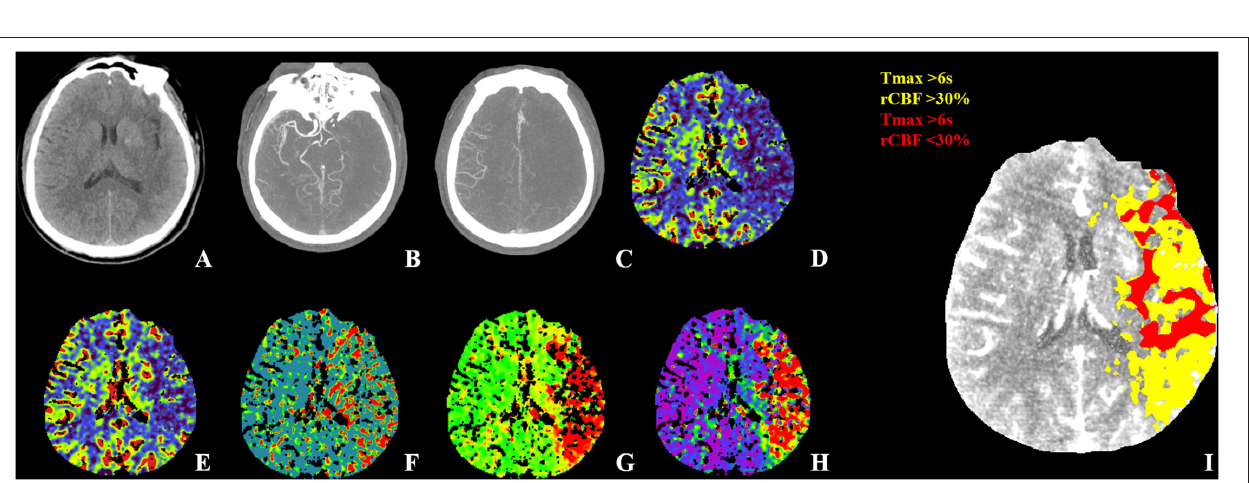
FIGURE 1 | WUS with good outcome. Fifty-four-year-old male patient WUS patient last seen well 6.4h before imaging. (A) The NECT didn’t show any hypodensity with ASPECTS 10. (B) CTA-MIP showed right distal M1 segment occlusion with CBS 8. (C) CTA-MIP showed collateral filling nearly 100% of the MCA flow territory with collateral score three. The CTP showed (D) a large area with decreased CBF, (E) a smaller area with decreased CBV and (F–H) a large area with increased MTT, TTP, and Tmax. The CTP summary map (I) showed 76ml of Tmax > 6s (yellow) and 34.93ml of < 30% rCBF decrease (red). The patient was treated EVT and showed good recovery with a 90-day mRS of one. WUS, wake-up stroke; ASPECTS, Alberta Stroke Program Early CT Score; MIP, maximum intensity projection; CBS, clot burden score; MCA, middle cerebral artery; EVT, endovascular thrombectomy; mTICI, modified Thrombolysis In Cerebral Infarction; mRS, modified Rankin Scale.